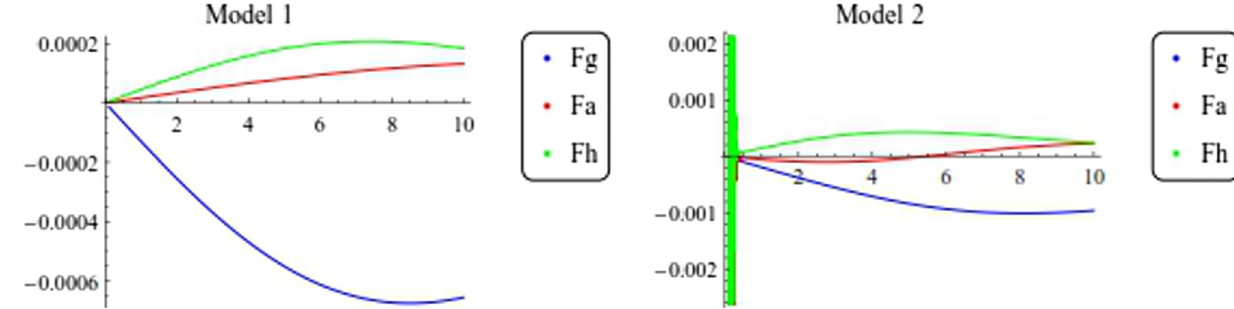
Fig. 9 Graph describing F g , F h and F a with r (km)